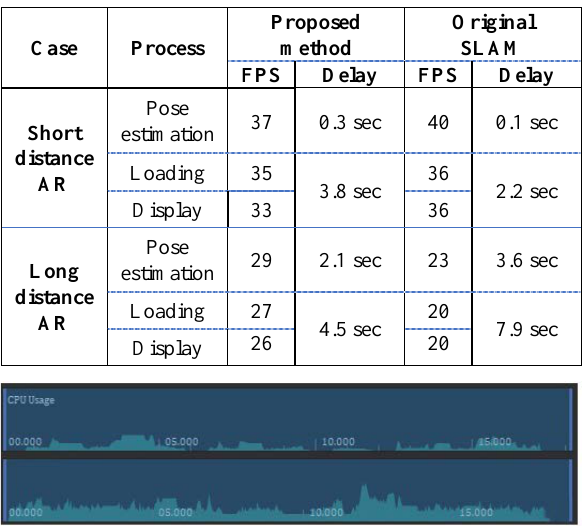
Table 4 . Metrics on UI thread, namely the main thread, at pose estimation, loading and drawn time.